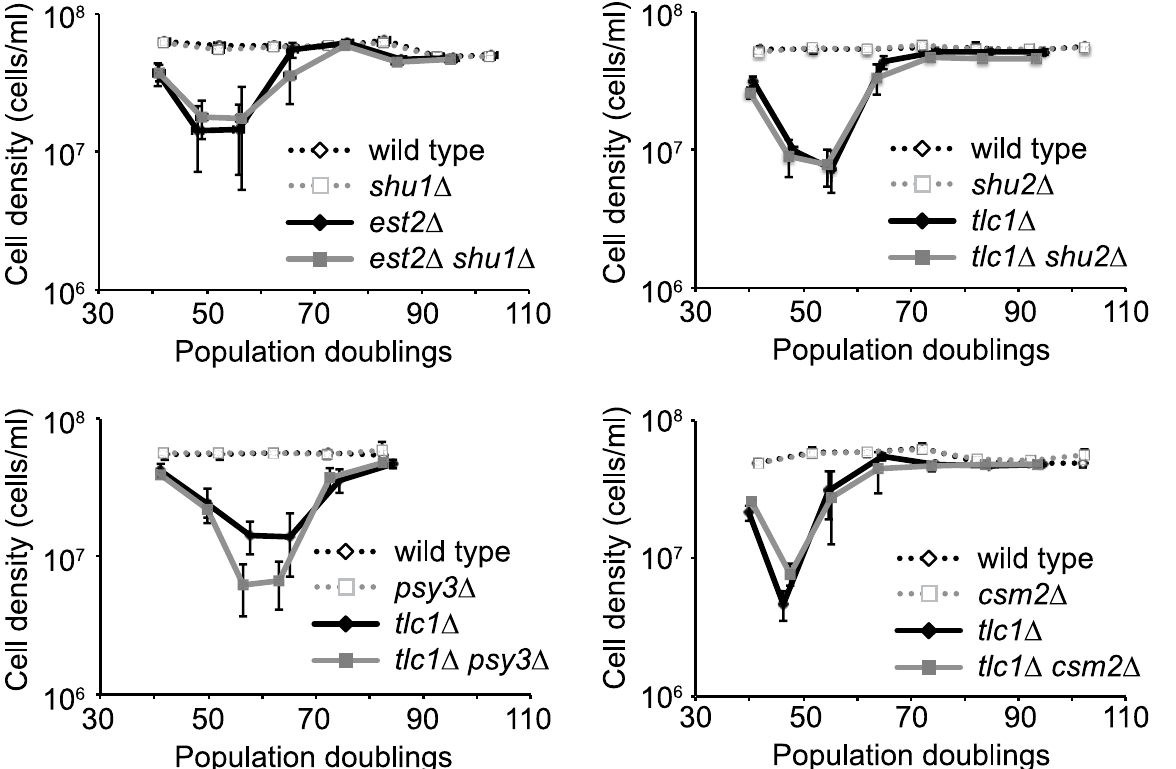
Fig 1. The Shu complex does not influence the rate of senescence or survivor formation. est2 Δ /EST2 shu1 Δ /SHU1 (top left), tlc1 Δ /TLC1 shu2 Δ /SHU2 (top right), tlc1 Δ /TLC1 psy3 Δ /PSY3 (bottom left), and tlc1 Δ /TLC1 csm2 Δ /CSM2 (bottom right) diploid strains were sporulated to generate the indicated haploid strains, which were subjected to a liquid culture senescence assay as described in the Materials and Methods. For each experiment, 2 – 3 isolates of each telomerase-positive strain and 4 – 5 isolates of each telomerase-negative strain were followed. The mean cell densities and standard errors of the means are